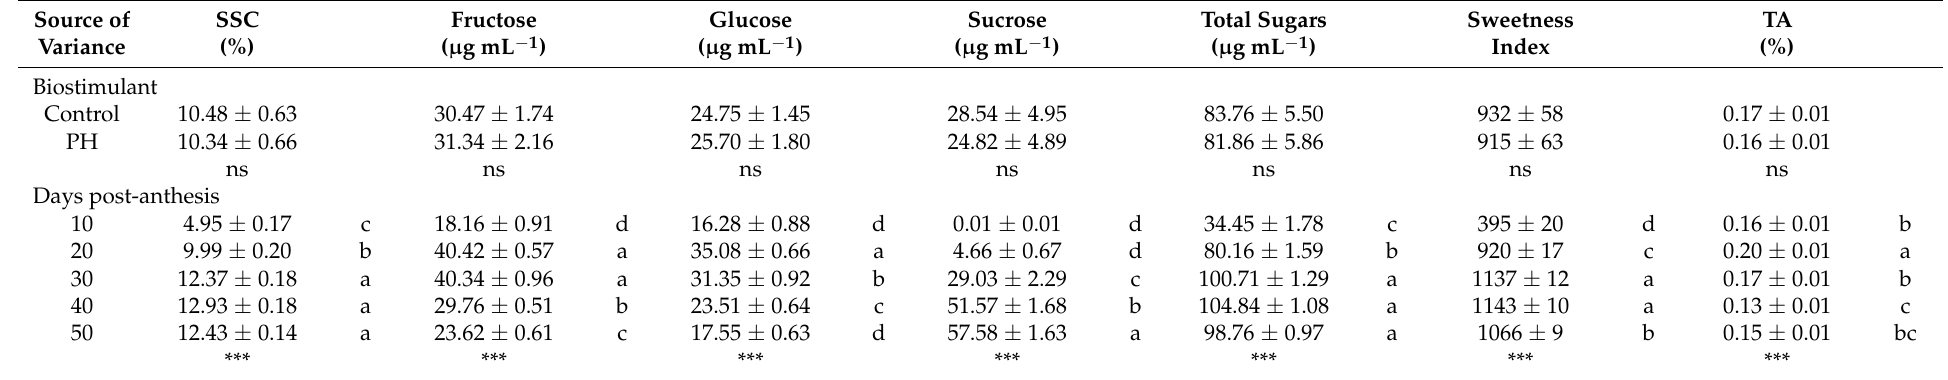
Table 3. Mean comparisons for fruit content in soluble solids (SSC), glucose, fructose, sucrose, total soluble carbohydrates, sweetness index, and titratable acidity (TA) obtained